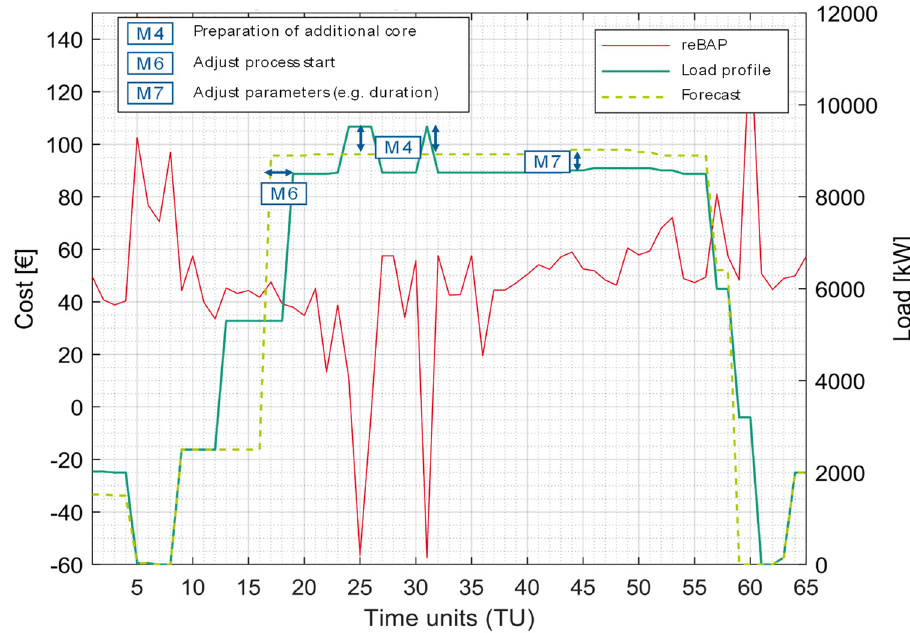
Figure 8. Load profile before (light green dashed line) and after the measure implementation (dark green line). For reference, the reBAP price is included.